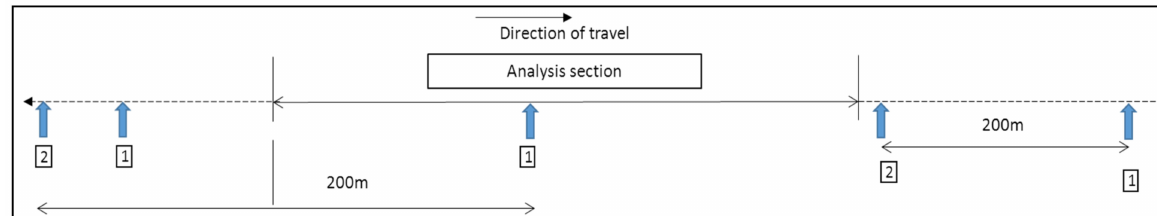
Figure 11. Hybrid time-distance separation scheme for simulating two pantograph